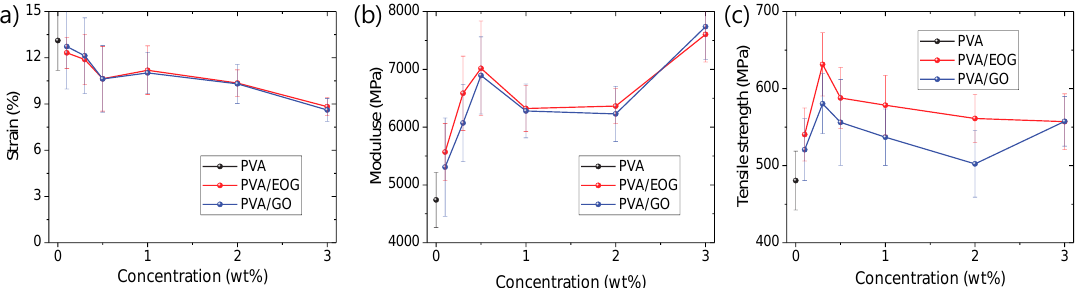
Figure 5. ( a ) Tensile strain, ( b ) Young’s modulus, and ( c ) tensile strength of polyvinyl alcohol (PVA)-only (black), PVA / edge-selectively oxidized graphene (EOG) composite (red), and PVA / graphene oxide (GO) composite fibers (blue).